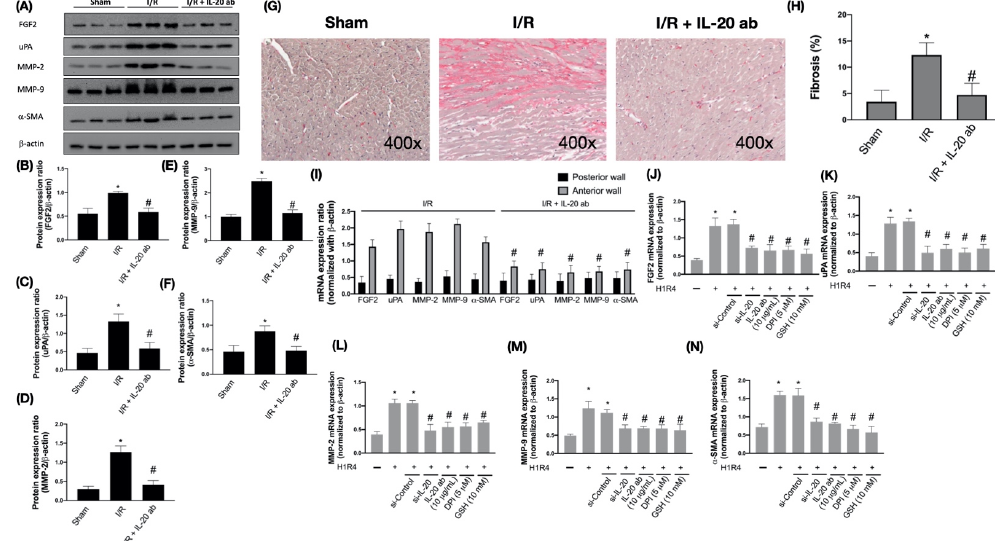
Figure 5. The effect of interleukin (IL)-20 antibody on ischemia/reperfusion (I/R)-induced upregulation of cardiac remodeling-related factors and fibrosis. Sprague Dawley rats receiving sham operation or I/R treatment were studied. In the IL-20 antibody treatment group, animals were injected with 5 mg/kg IL-20 antibody at the phase of reperfusion. The left ventricular tissues were collected for Western blotting assay. Representatives of Western blot ( A ), and the densitometric analysis of fibroblast growth factor 2 (FGF2) ( B ), urokinase-type plasminogen activator (uPA) ( C ), matrix metallopoateinase-2 (MMP-2) ( D ), matrix metallopoateinase-9 (MMP-9) ( E ), and α -smooth muscle actin ( α -SMA) ( F ) were shown. Masson’s trichrome staining was done to detect fibrotic tissue. Representative images of Masson’s Trichrome staining ( G ) and quantification ( H ) of fibrosis areas were shown. ( I ) The mRNA levels of remodeling-related factors in ischemic area (anterior ventricular wall) and nonischemic area (posterior ventricular wall) were investigated by quantitative real-time polymerase chain reaction assays. The data were presented as the mean ± standard deviation (SD) of six animals in each group. ( J – N ) The mRNA expression of fibrosis factors in H9C2 cells after H/R was examined. H9C2 cells that had been first exposed to hypoxia chamber with oxygen-glucose deprivation (OGD) for 1 h were moved into the normoxia chamber with high glucose medium for further 4 h, a condition abbreviated as H1R4. In some cases, cells were transfected with si-Control or si-IL-20 for 48 h before OGD. In the IL-20 antibody treatment group, 10 µ g/mL IL-20 antibody was added to medium during hypoxia/reoxygenation (H/R). Glutathione (GSH), an antioxidant, was used for mitigating oxidative stress. Diphenyleneiodonium chloride (DPI), a nicotinamide adenine dinucleotide phosphate (NADPH) oxidase inhibitor, was used to inhibit H/R-induced NADPH oxidase activation. Data were presented as the mean ± SD of three different experiments. (* indicating p < 0.05 compared to the sham group or normoxia control cells; # indicating p < 0.05 compared to the I/R group or H/R cells). Sham: thoracotomy without ischemia/reperfusion; I/R: thoracotomy with ischemia/reperfusion; I/R + IL-20 ab: thora-cotomy with ischemia/reperfusion plus IL-20 antibody injection. “ − ” indicated cells were exposed to normoxia cham-ber; “+” indicated cells were exposed to hypoxia chamber for 1 h followed by 4 h